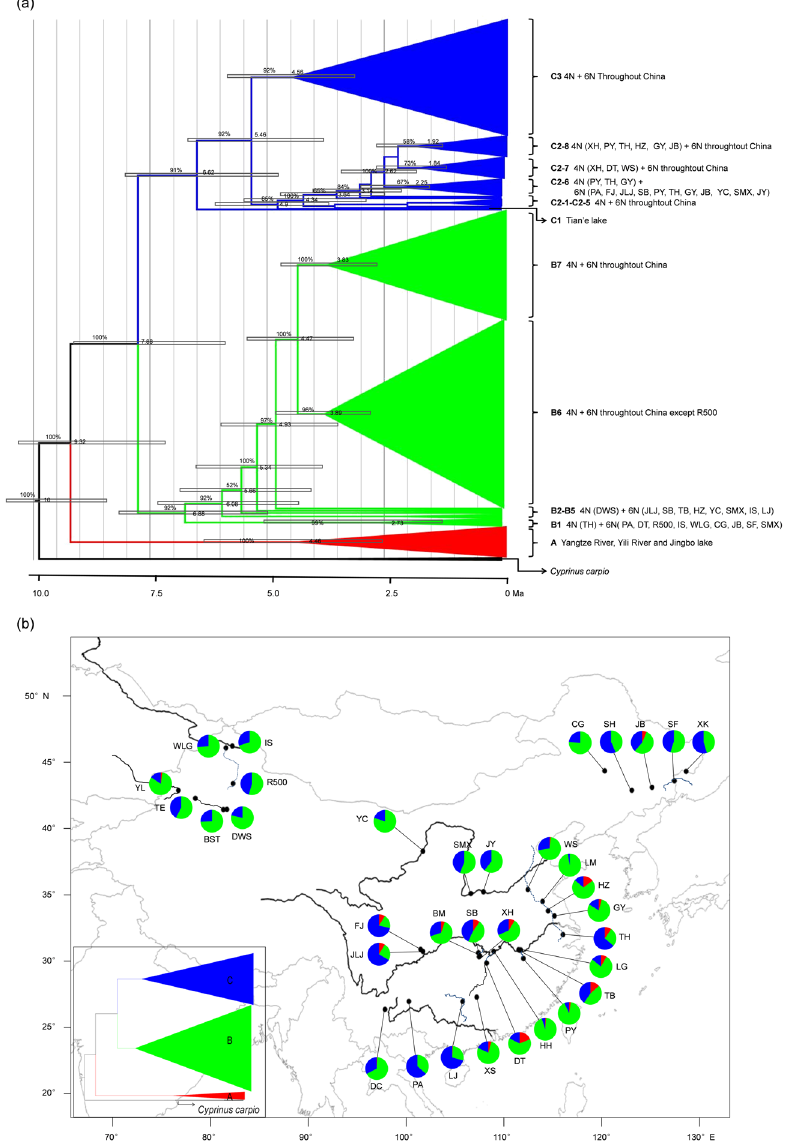
Figure 6. Simplified time-calibrated phylogeny tree ( a ) and relative frequency of three different lineages in 34 sampled populations ( b ). Values above branches indicate Bayesian posterior probabilities, and divergence times are shown near each node. Tf allele of Cyprinus carpio is used as outgroup. Tf alleles in each lineage are described in detail in Fig. S2. 4N and 6N are the abbreviation of tetraploids and hexaploids respectively. Each lineage is uniquely colored and is matched with the color of pie-diagrams in Fig. 5. The map was created in ARCMAPv.9.3 (ESRI, Redlands, CA, USA)